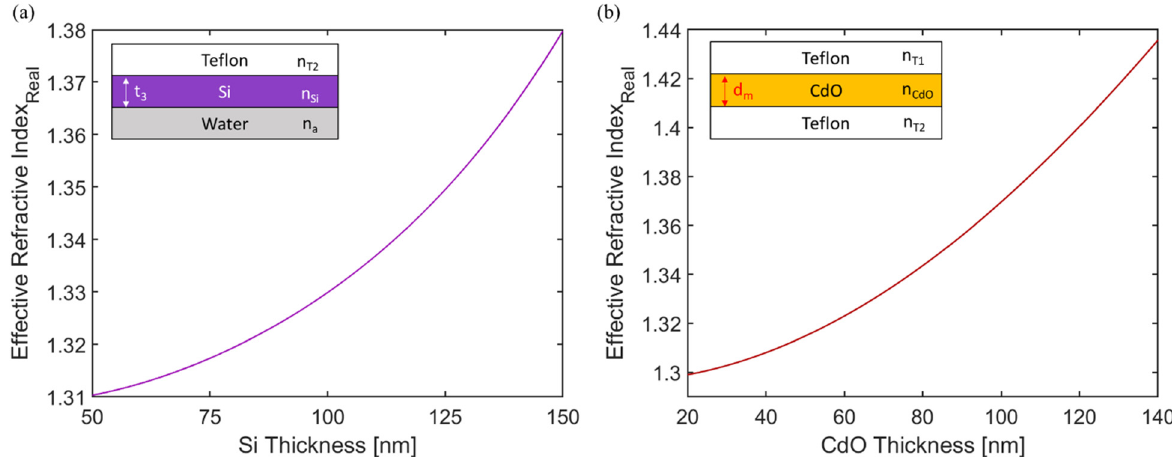
Figure 4. Modal indices of ( a ) the 3-layer Teflon/Si/Water DWG structure and ( b ) the 3-layer Teflon/CdO/Teflon plasmonic structure.